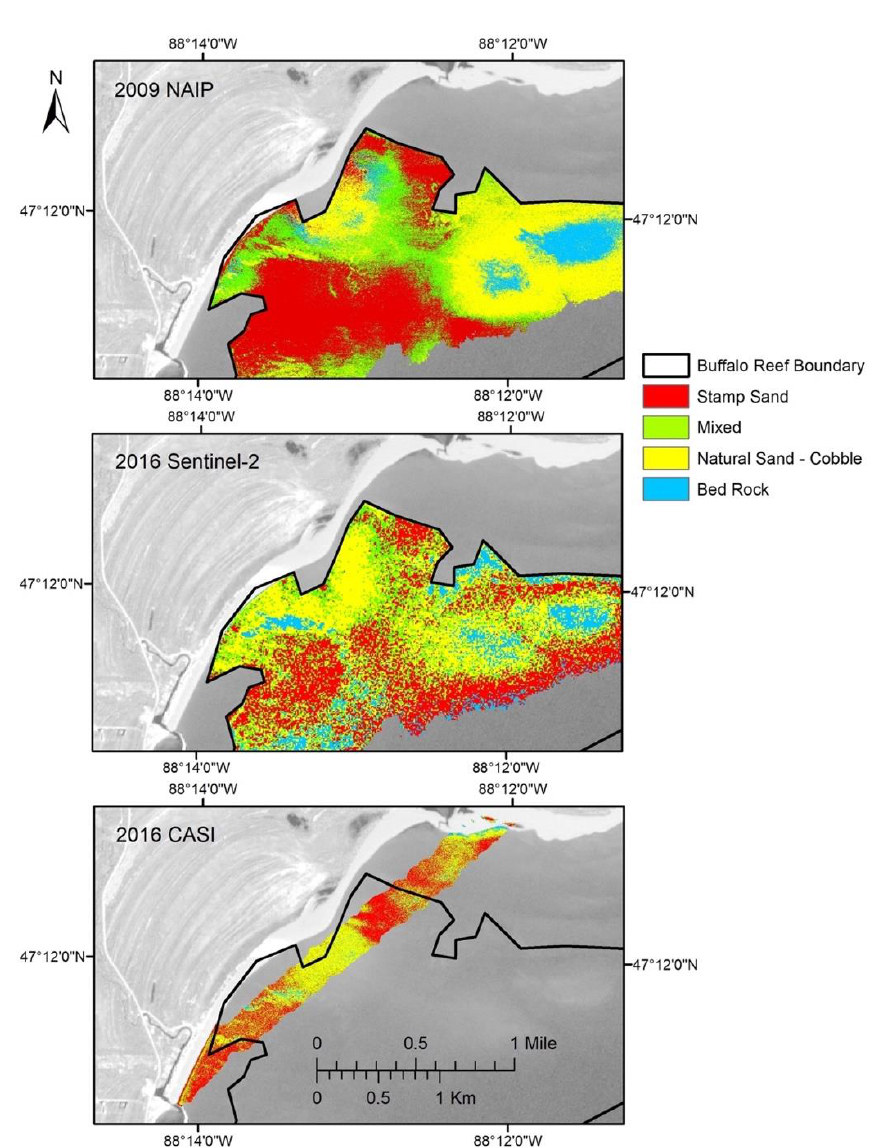
Figure 14. Bottom Classification maps: The top panel is the bottom type classification from the 2009 NAIP, whereas the middle panel is from Sentinel-2 imagery. The bottom panel is a single image strip, from airborne CASI. Relatively good agreement exists between the three bottom classifications for shallow waters. However, the Sentinel-2 is more variable and suggests stamp sand ringing the deep margins of Buffalo Reef, a pattern contrary to direct particle counts.